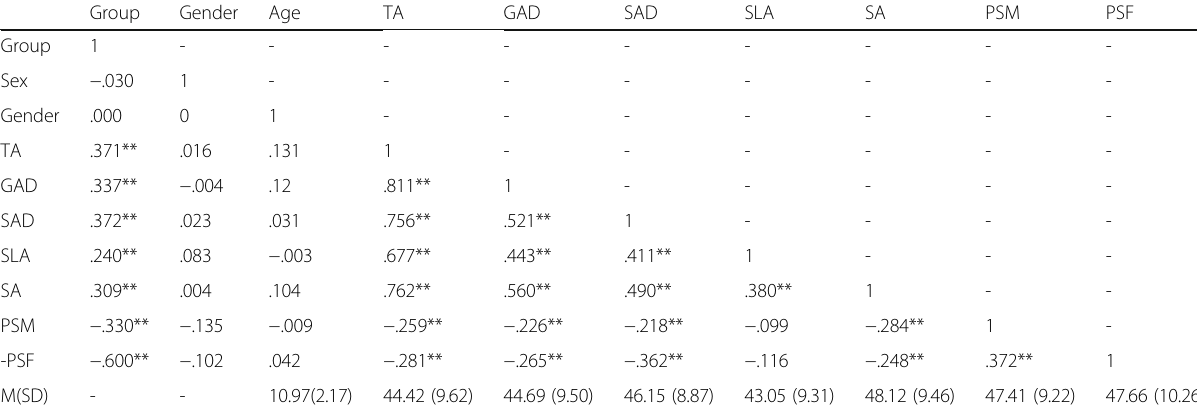
Table 1 Correlations, means and standard deviations for the variables in the study ( N = 200) Group